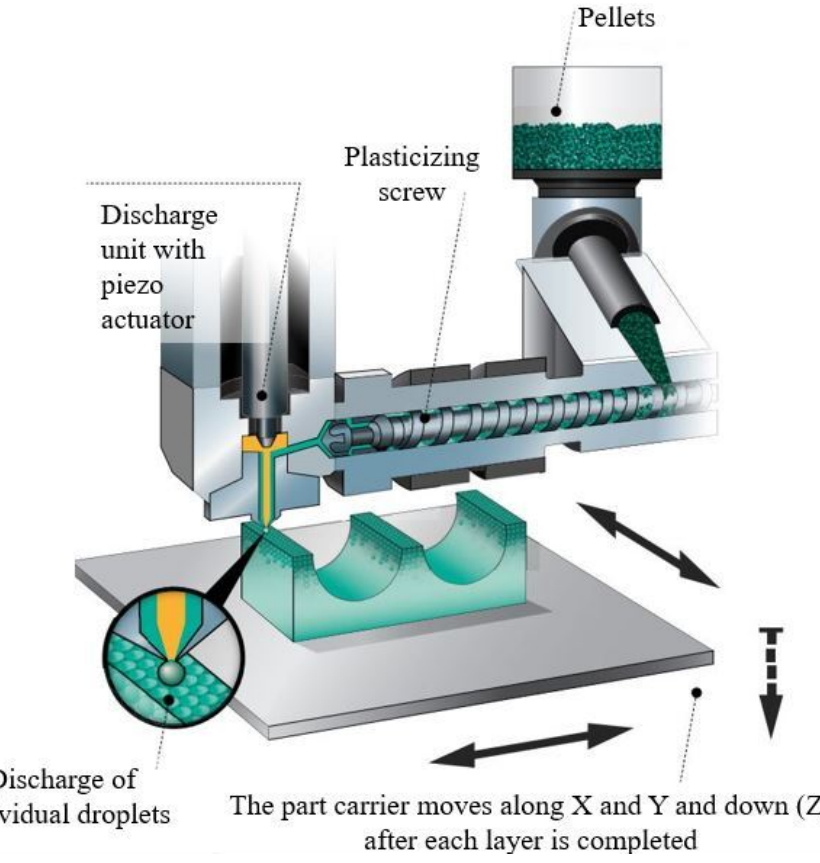
Figure 1 . ARBURG Plastic Freeforming (APF) process (adapted from arburg.com). Figure 1. ARBURG Plastic Freeforming (APF) process (adapted from arburg.com).